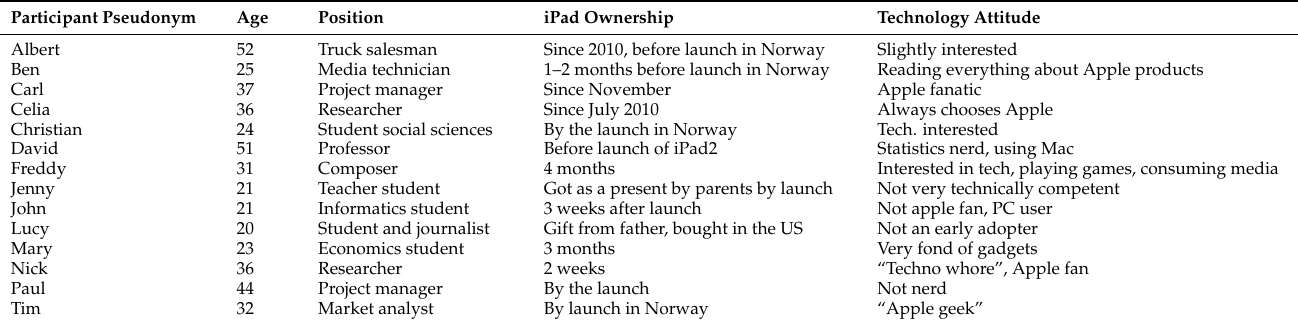
Table 1. Overview of